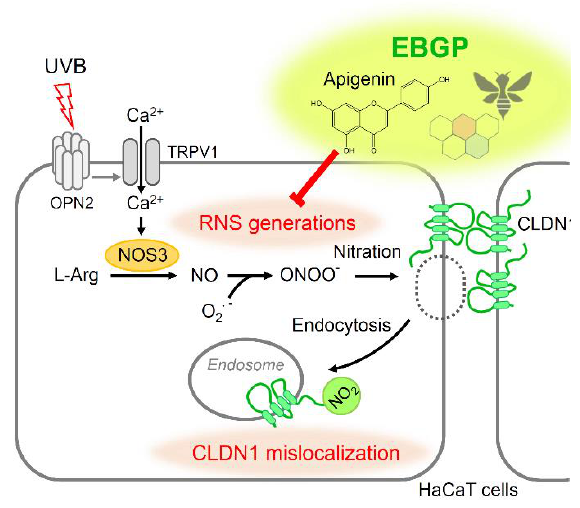
Figure 8. A proposed scheme for the protective effect of EBGP and flavonoids against weak UVB- induced barrier dysfunction in HaCaT cells.